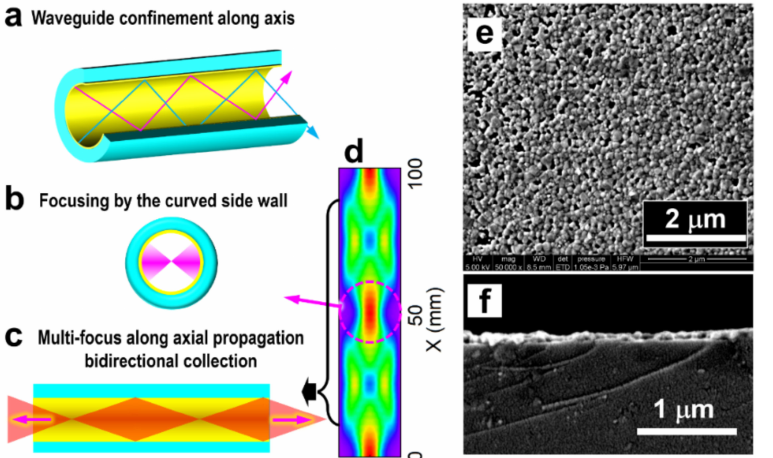
Figure 2. Multifold optical feedback and enhancement mechanisms. ( a ) Confinement of the excitation and Raman light beams by the microcavity formed by the AgNP-coated inner wall of the hollow fiber. ( b ) Focusing the reflected light beam by the curved surface of the inner wall. ( c ) Bidirectional collection of the Raman scattering light. ( d ) Simulation of the optical electric field distribution in the hollow fiber. ( e , f ) SEM images were measured on the top surface and the cross-sectional profile of the Ag-coating on the inner wall of the hollow